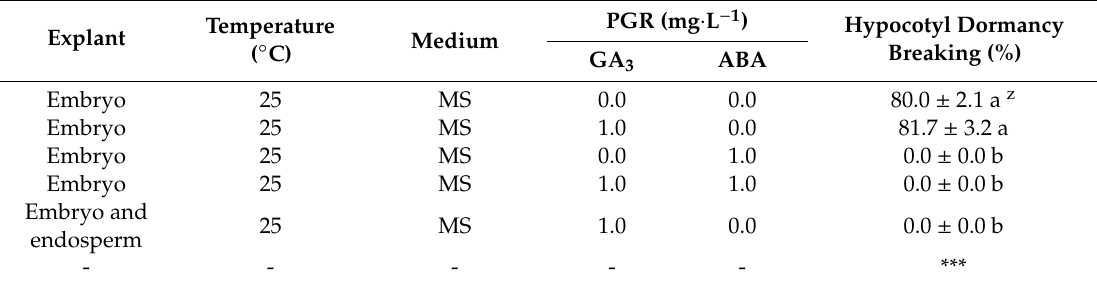
Table 2. The e ff ect of GA 3 , ABA, and endosperm on hypocotyl dormancy breaking. MS: Murashige and Skoog.